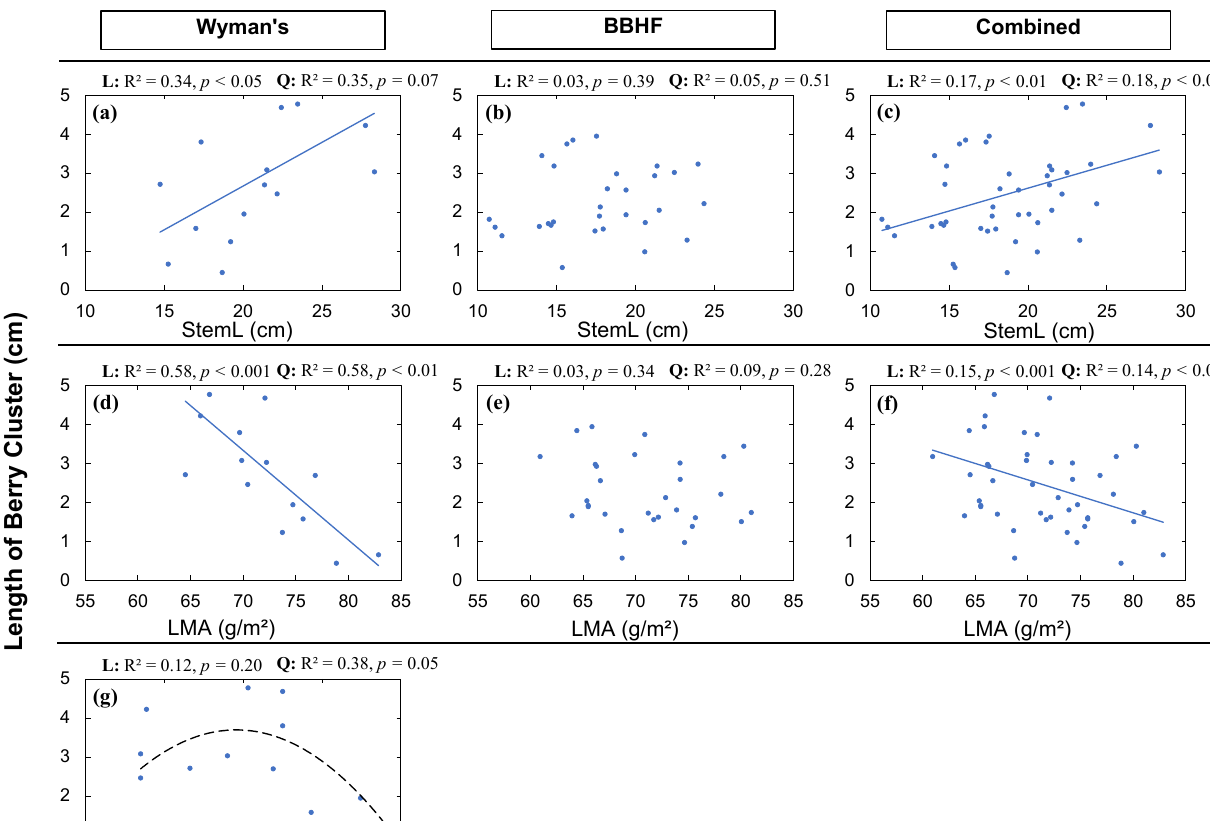
The length of a berry cluster in stem (LBC) was significantly related to StemL, LMA, and LeafT. However, relationships within and across fields were not consistent (Figures 3 and 6). This was also the case for yield (Figure 3) and NBS (Figure 5). We found a significant positive linear (Figure 6a: R 2 = 0.34, p < 0.05) and marginally significant quadratic (Figure 6a: R 2 = 0.35, p = 0.07) relationship of LBC with the StemL among the genotypes in the Wyman’s field, whereas significant relationships were absent for the BBHF field. However, we found significant linear and quadratic relationships (Figure 6c) for the combined data from the two fields. The relationships of LMA with the LBC were similar to what we found for NBS (Figure 6d–f). We found significant negative linear and quadratic relationships between LBC and LMA for the Wyman’s field (Figure 6d: R 2 = 0.58, p < 0.001) and for the combined data of the two fields (Figure 6g: R 2 = 0.15, p < 0.05). No significant relationship was found for the BBHF field. A quadratic relationship was found between LeafT and LBC (Figure 6g: R 2 = 0.38, p < 0.05).